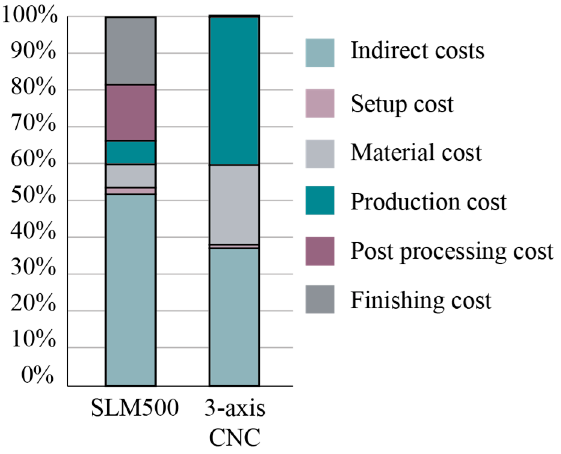
Figure 13. Distribution of the manufacturing costs.